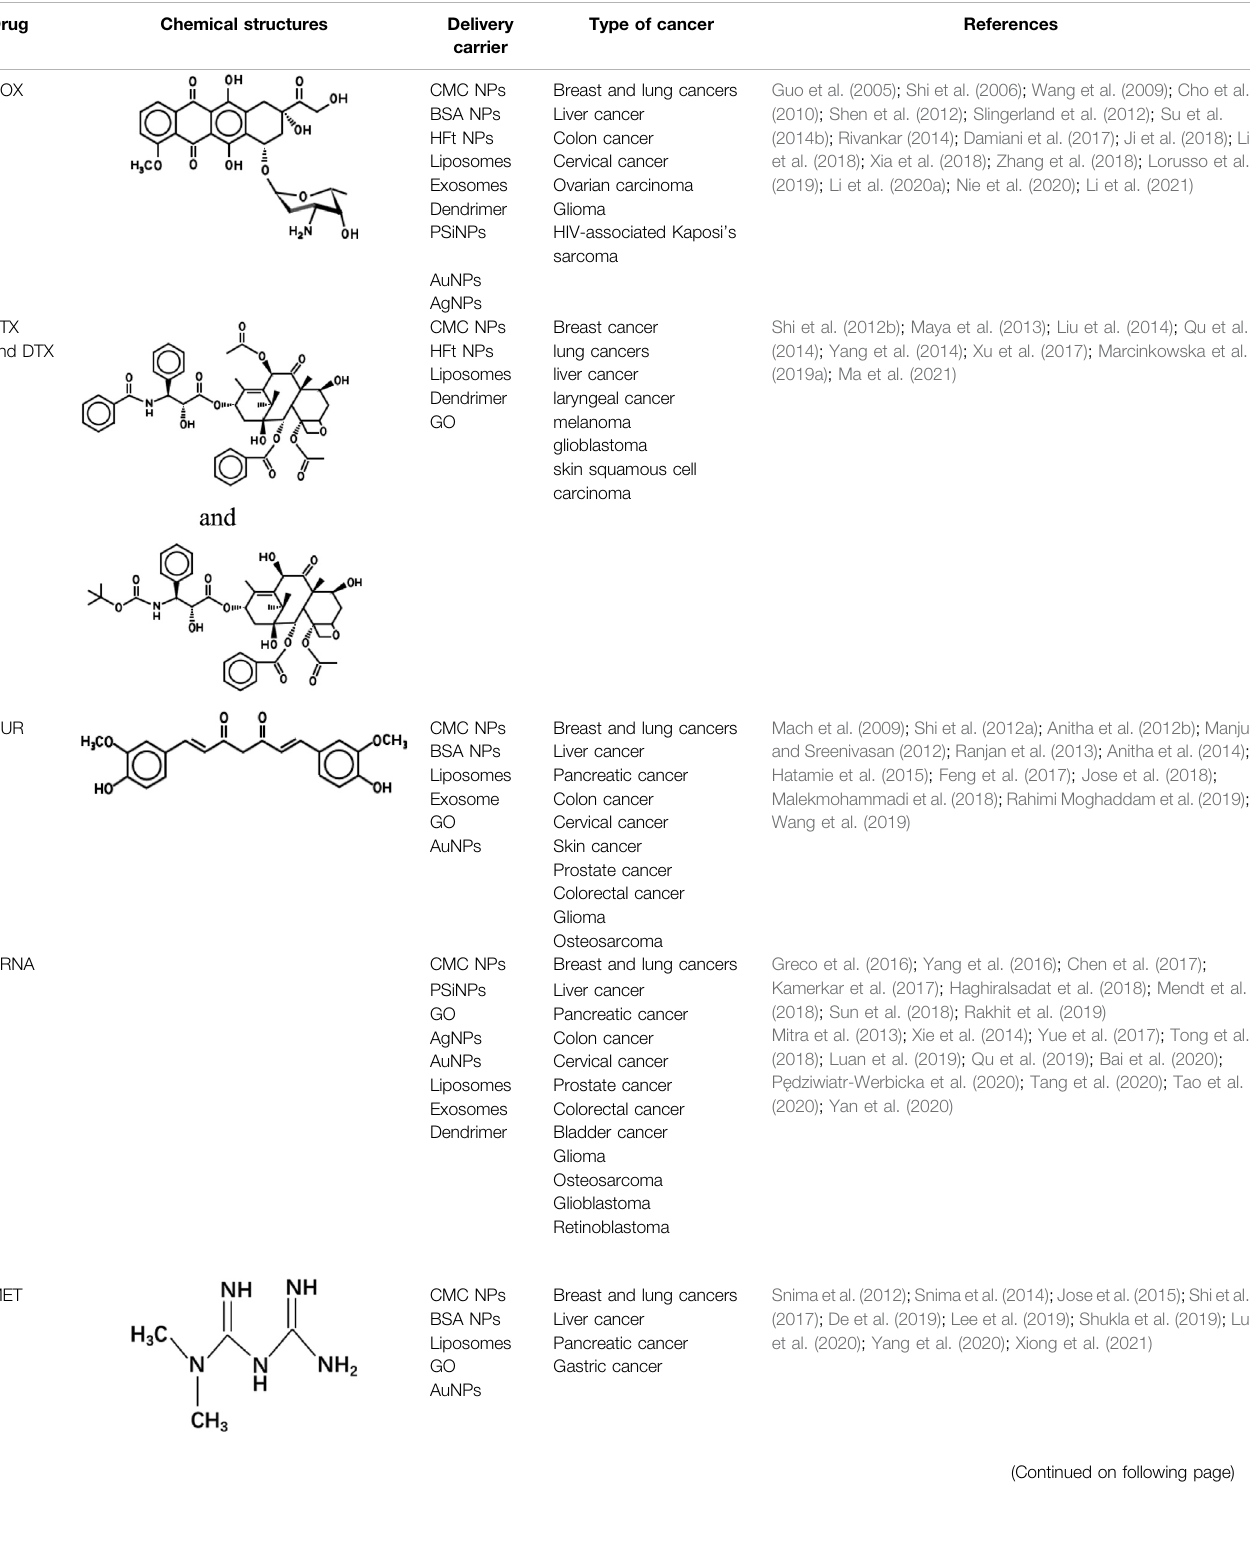
TABLE 1 | Different anticancer drugs, chemical structures, delivery carrier, and types of